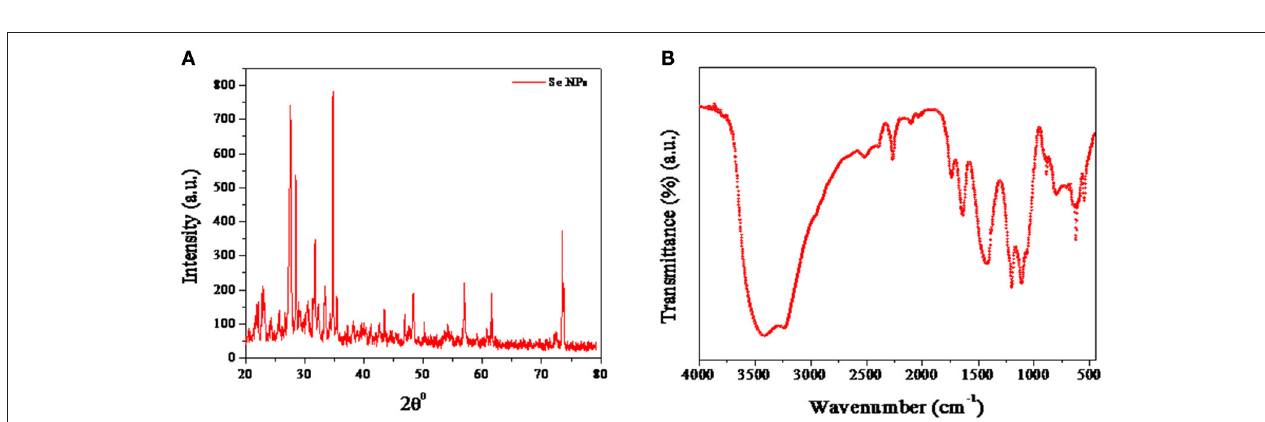
FIGURE 2 | Characterization of SeNPs@HP. (A) XRD pattern of SeNPs@HP. (B) FTIR analysis of SeNPs@HP showing peaks at 3,420 cm − 1 , corresponding to the O-H stretch; 1375 cm − 1 , the C-H stretch and 1,050 cm − 1 , the C-O stretch.